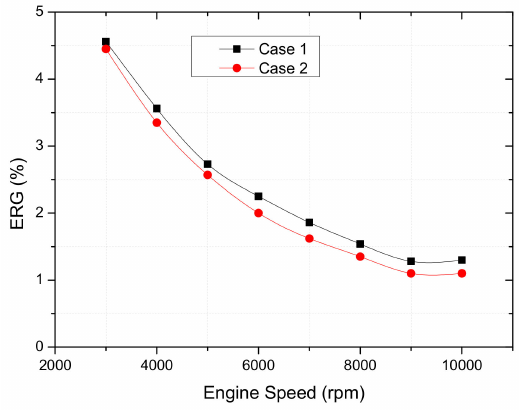
Figure 9. Comparison of ERG between the original and new valve mechanisms.